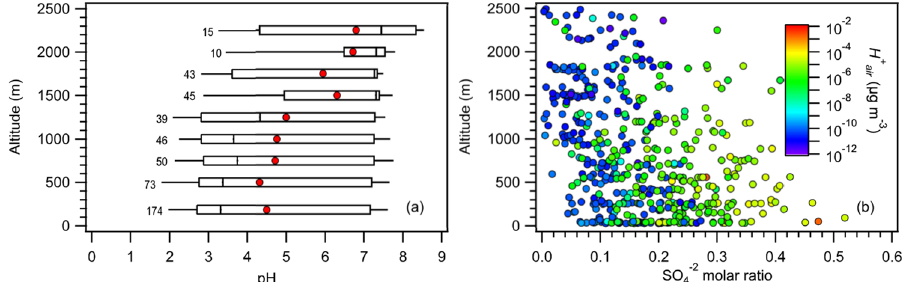
Figure 4. ( a ) Vertical profile of PM 1 pH (250 m altitude-binned) from 0 to 2500 m altitude. Standard box-and-whisker plots are shown, with the 90th and 10th percentile data indicated by black error bars. The top and bottom of the box are the interquartile ranges (75th and 25th percentile) centered around the median value (50th percentile). The red symbols denote mean pH values. The number of points considered for each bin are also shown. ( b ) Vertical profile of the SO 42 − molar ratio (colored by H + air